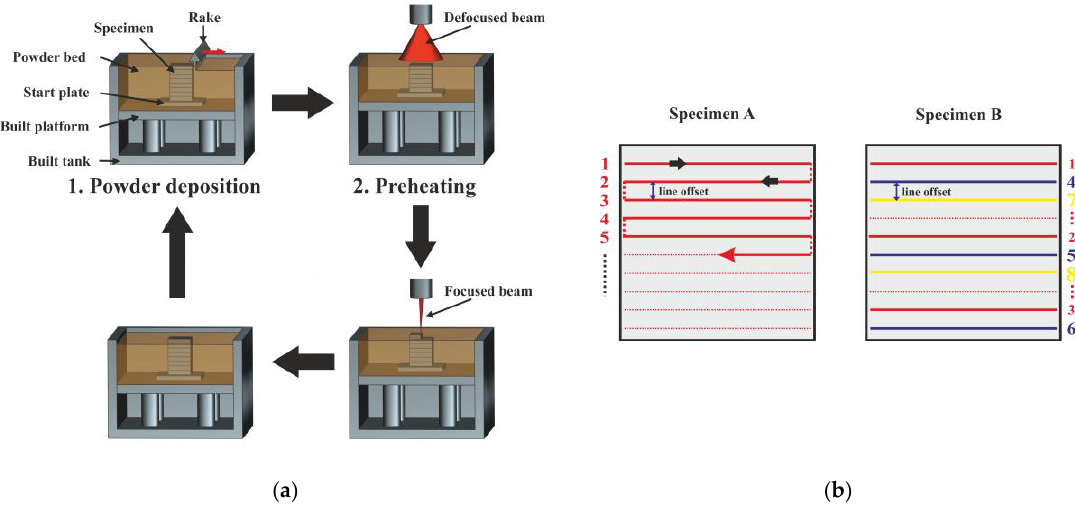
Figure 1. Schematic illustration of SEBM procedure: ( a ) SEBM processing steps; and ( b ) two types of scan strategies referred to as line order 1 (Specimen A) and 5 (Specimen B), and their subsequent processing steps. Table 2. Parameters used for SEBM processing of Specimens A and B.